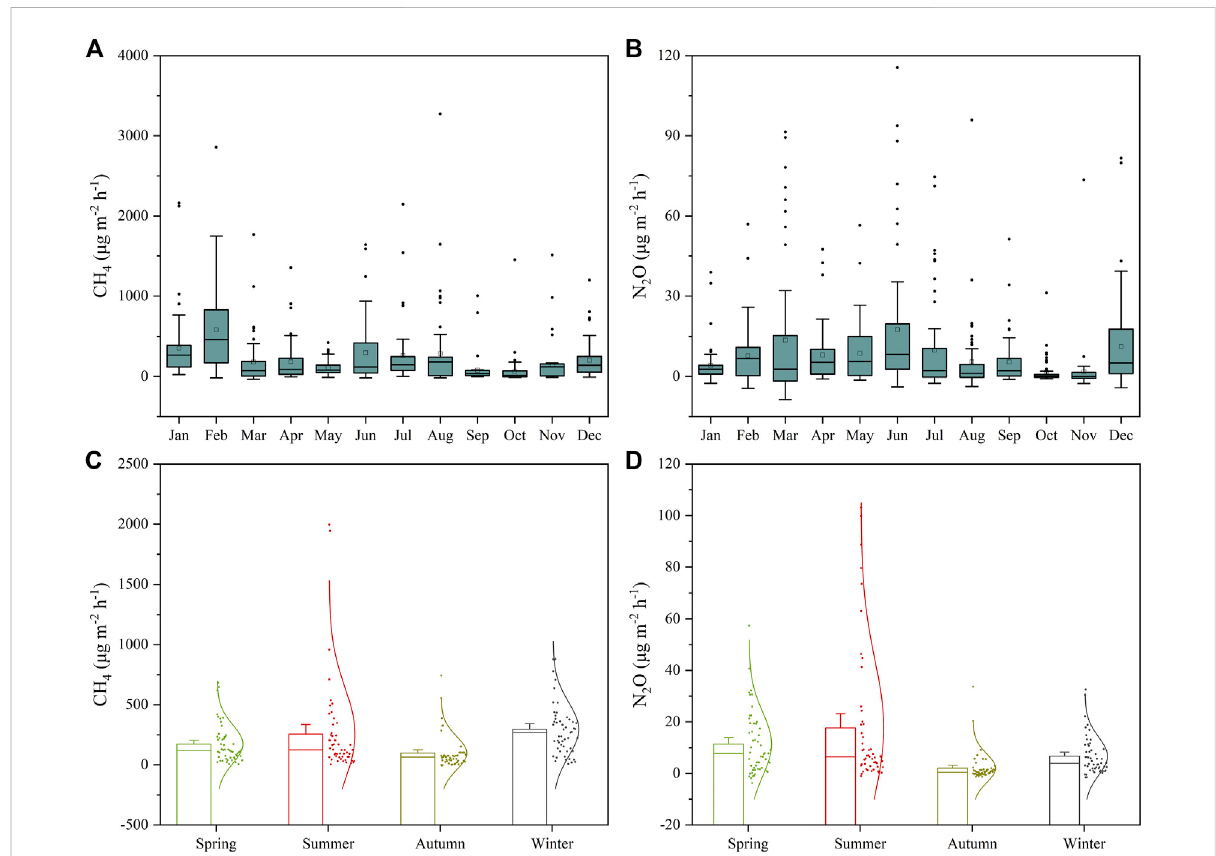
FIGURE 4 TemporalvariationofmonthlyCH 4 (A) andN 2 O (B) fl uxesandseasonalCH 4 (C) andN 2 O (D) fl uxesinthestudiedpondsFor (A,B) ,lineswithinthe boxes give the median, boxes represent the 25th and 75th percentile, indicating the lowest and highest values, excluding outliers, and circles represent outliers and extremes; For (C,D) , lines within the boxes give the standard error, the mean and the median, representatively. The curves are normal distribution curves of all the sampling sites during different seasons).